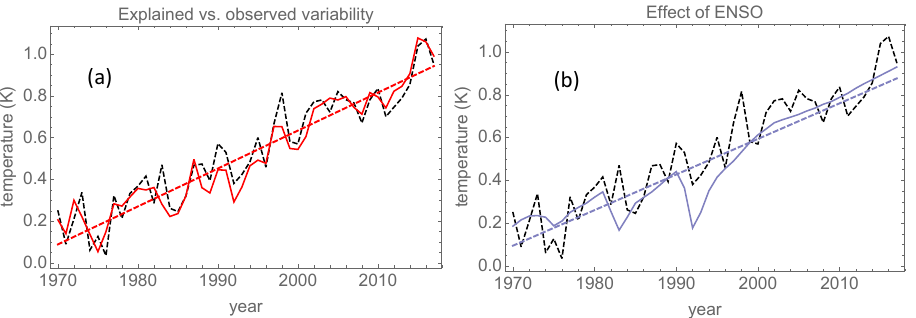
Figure 4. ( a ) A close-up on Figure 3a. The red, dashed line is a linear fit to the red curve. ( b ) A close-up on Figure 3c. The blue, dashed line is a linear fit to the blue